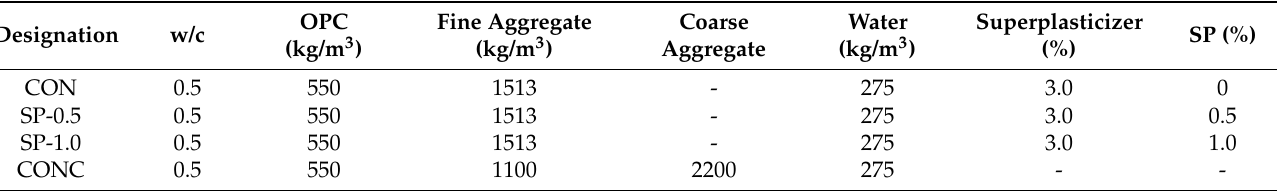
Table 2. Mixture proportions for bare specimens.